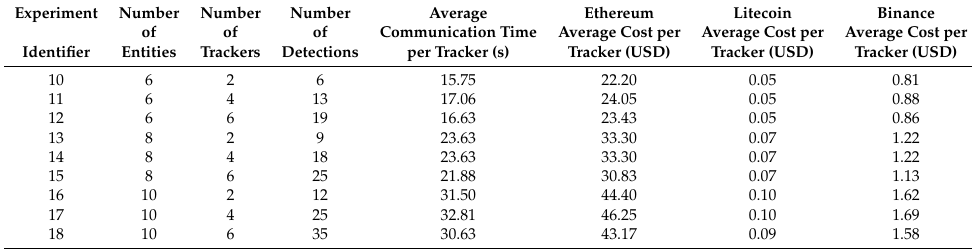
Table 3. Experimental results using RFID as wireless